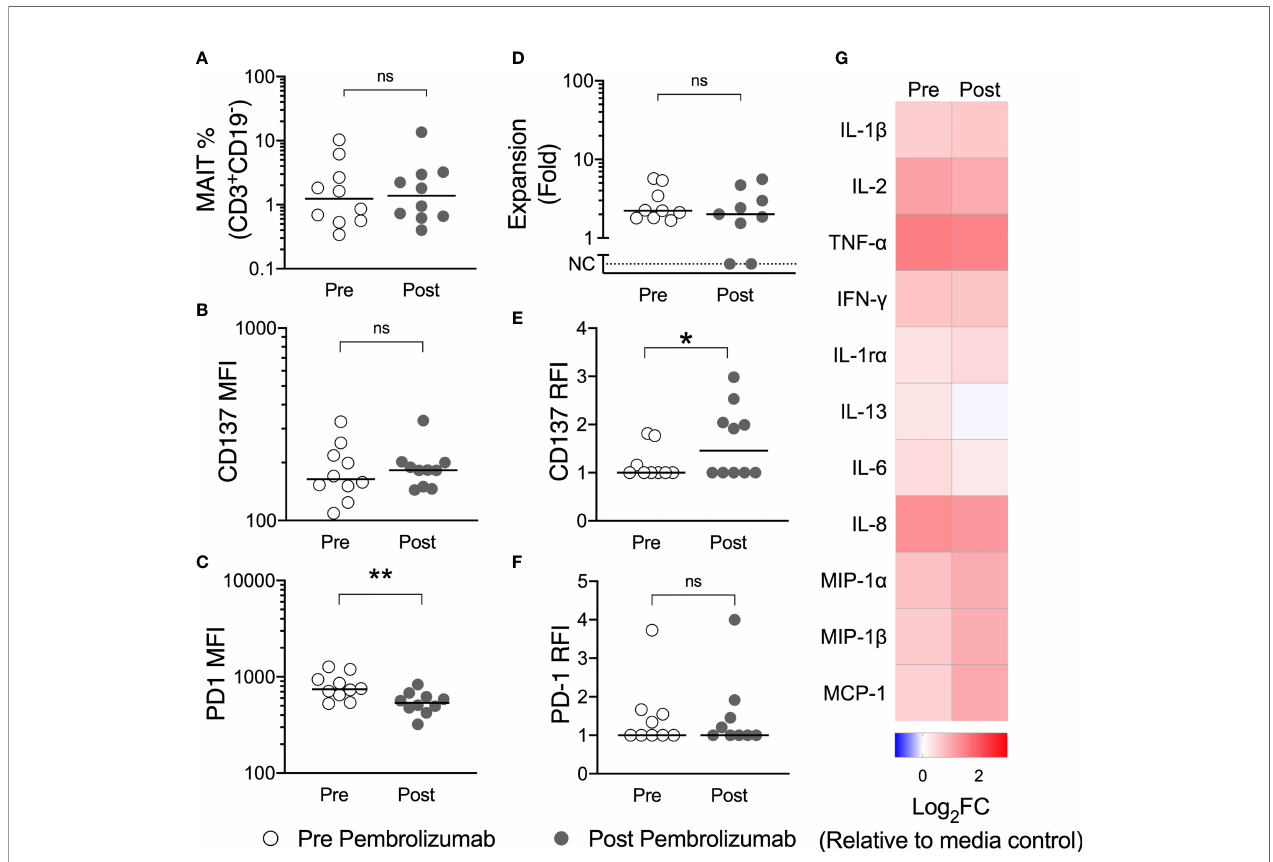
FIGURE 6 | Pembrolizumab does not deplete MAIT-cells in vivo nor does it enhance MAIT-cell function ex vivo. The circulating frequency of MAIT-cells (A) and their surface expression of CD137 (B) and PD-1 (C) in unstimulated PBMCs was compared for patients with melanoma before and after their fi rst dose of pembrolizumab. PBMCs were then cultured with 5-A-RU/MG for 7 days and the proliferation of MAIT-cells (D) and the upregulation of CD137 (E) and PD-1 (F) at the end of culture calculated. Mann-Whitney test. ns, no signi fi cance. *P < 0.05. **P < 0.01. No signi fi cant differences were observed for cytokines quanti fi ed in 72 hour culture supernatant for pre and post pembrolizumab samples (G) . N,